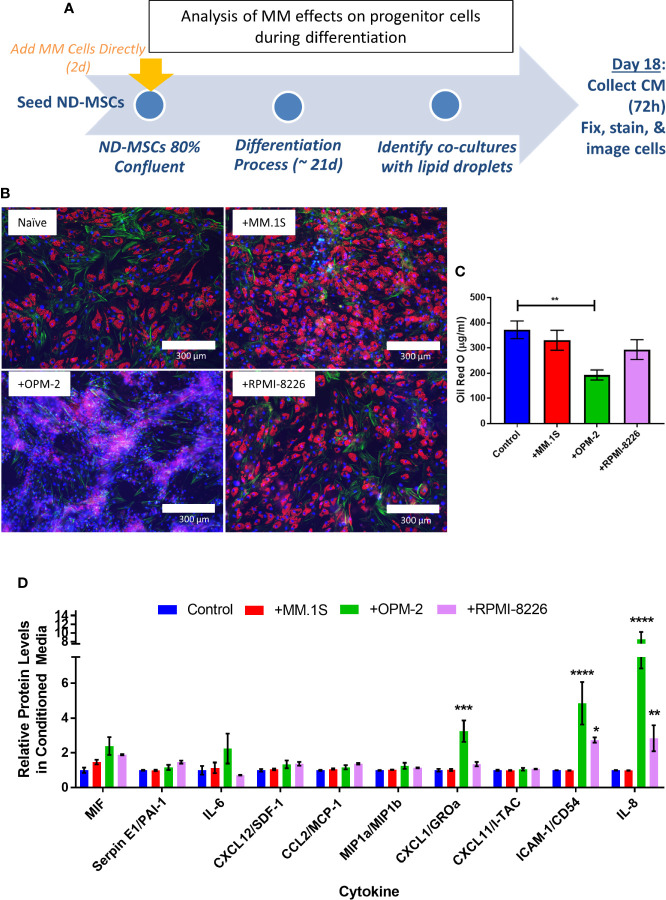
Direct co-culture of human mesenchymal stem cells (hMSCs) with myeloma cells reveals cell-line specific effects on lipid accumulation and cytokine production. Experimental design of co-culture experiment (A) where multiple myeloma (MM) cells (MM.1S, RPMI-8226, OPM-2) were added 2 days prior to the start of differentiation. Myeloma cells were allowed to persist during differentiation with adipogenic media. Fresh adipogenic media was incubator for 72 h prior to the collection of conditioned media. Conditioned media was collected and cells were fixed and stained on day 18 of differentiation, a few days prior to terminal differentiation. Adipocytes were fixed, stained (phalloidin=green, Oil Red-O=red, DAPI=blue), and imaged with a 10X objective after differentiation and co-culture with or without myeloma cells (B); images are from one hMSC donor, but are representative of n=3 donors. Lipid content was assessed by Oil Red-O staining, elution, and quantification (C). Cytokines were assessed in conditioned media by human cytokine array (R&D) (D); n=3 donors for each condition (control=naïve, +MM.1S, +OPM-2, +RPMI-8226). Significance was assessed via two-way ANOVA. *p < 0.05, **p < 0.01, ***p < 0.001, ****p < 0.0001.